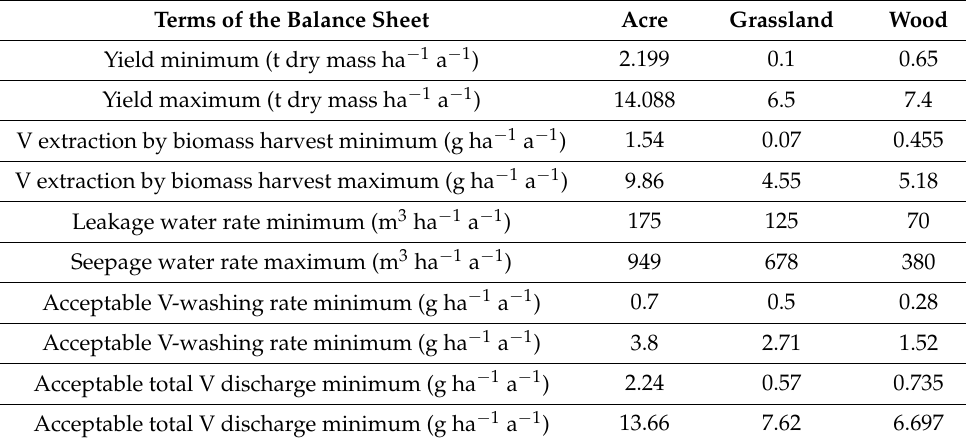
Table 15. Calculation of the acceptable V discharge in the typical German range (minimum and